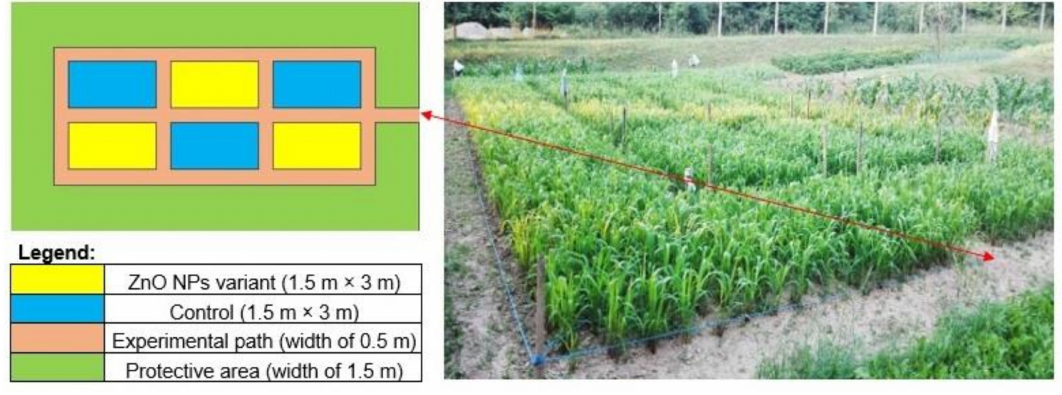
Figure 2. Experimental plan